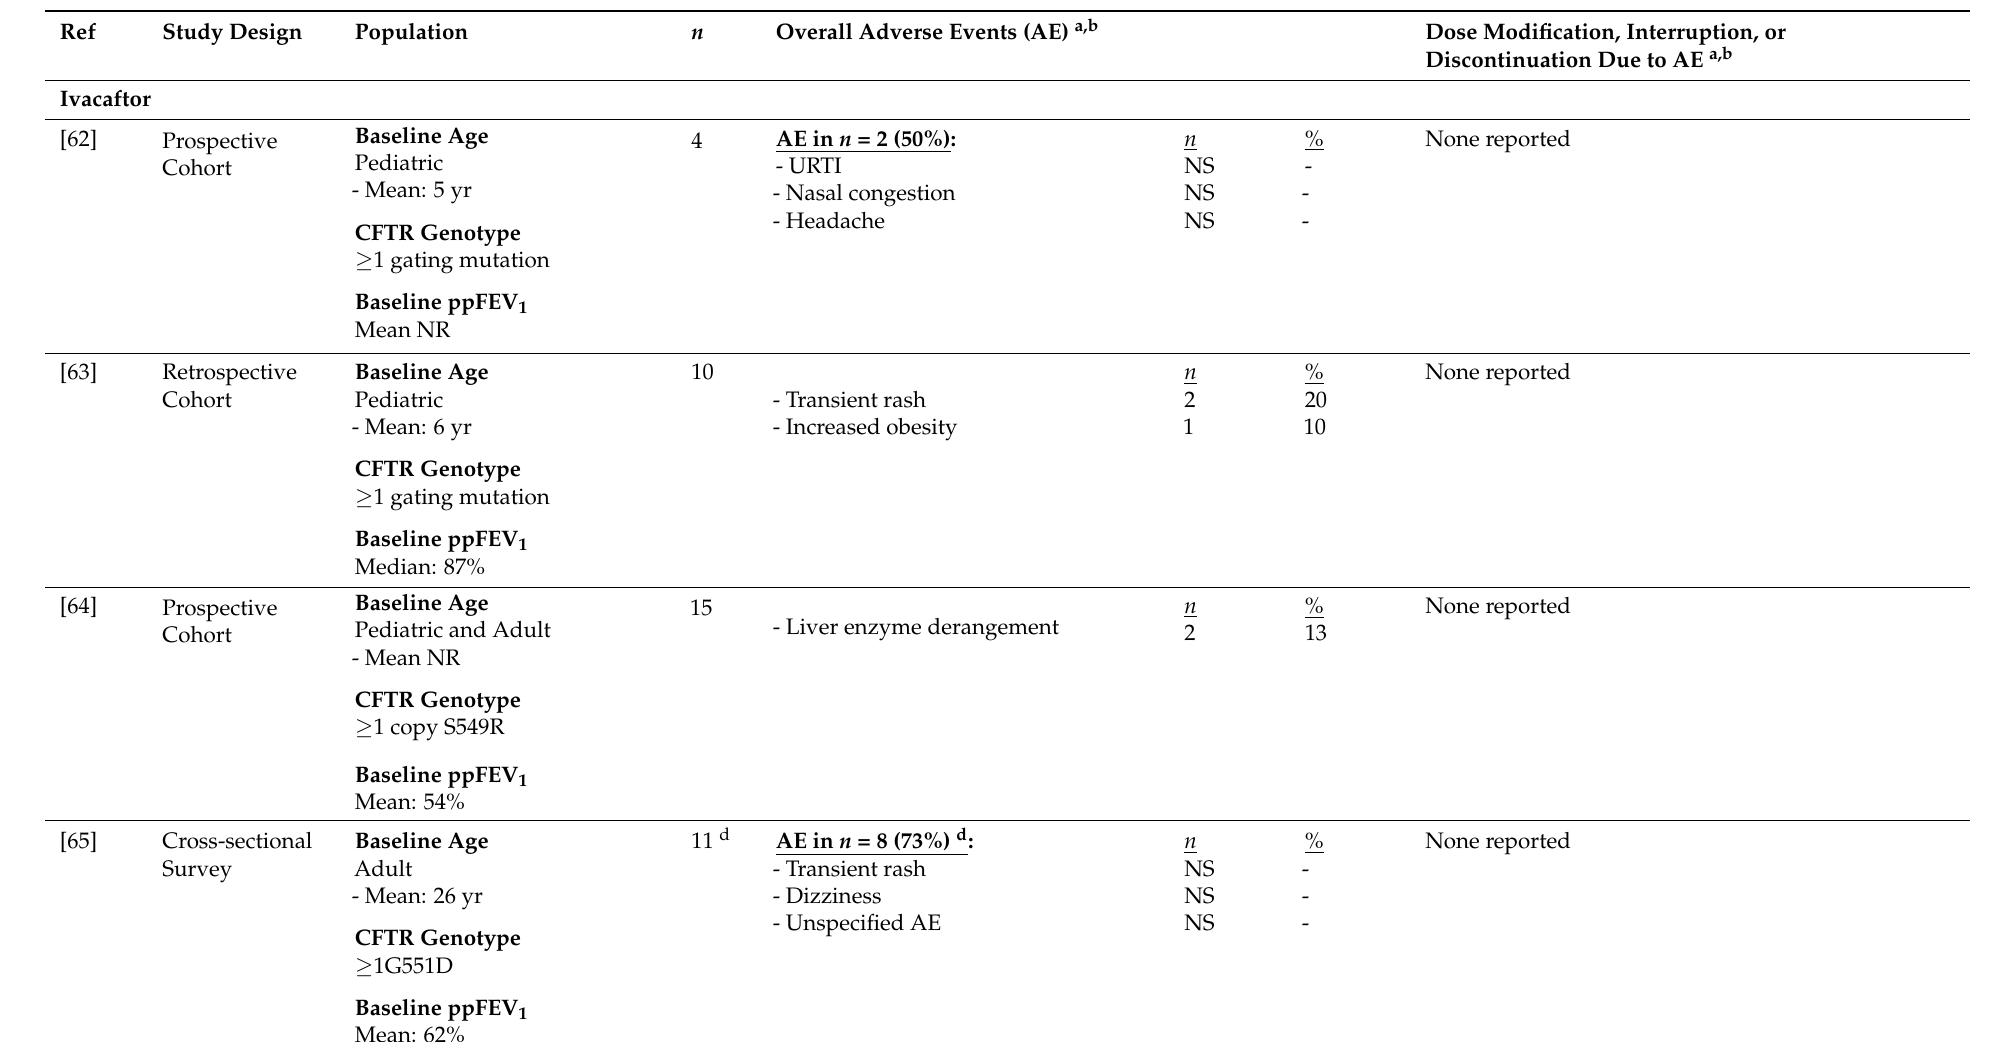
Table 2. Summary of characteristics and results of cohort or survey studies in abstract